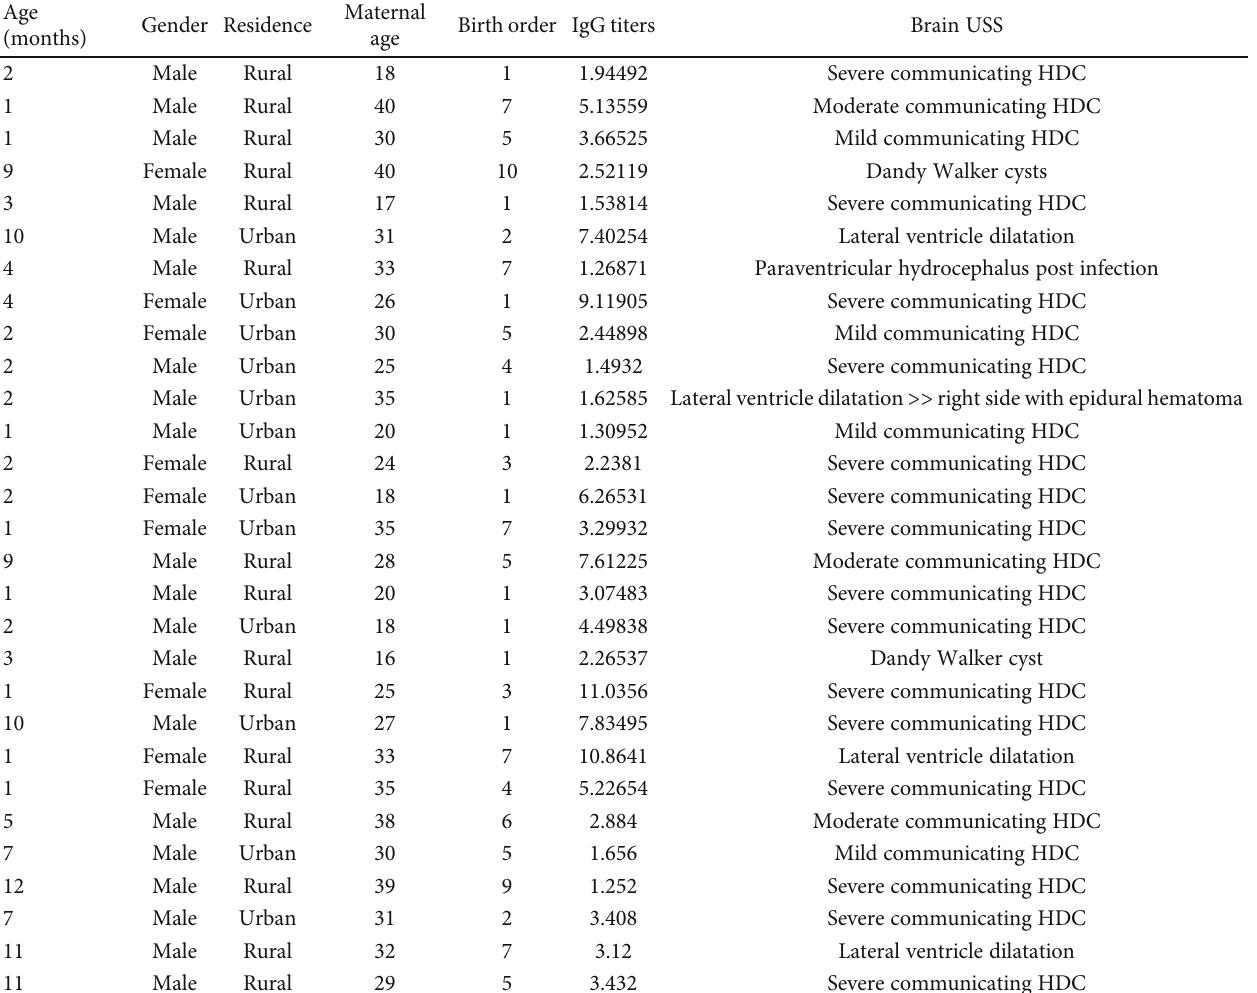
Table 6: Cranial ultrasound patterns among T. gondii IgG-seropositive